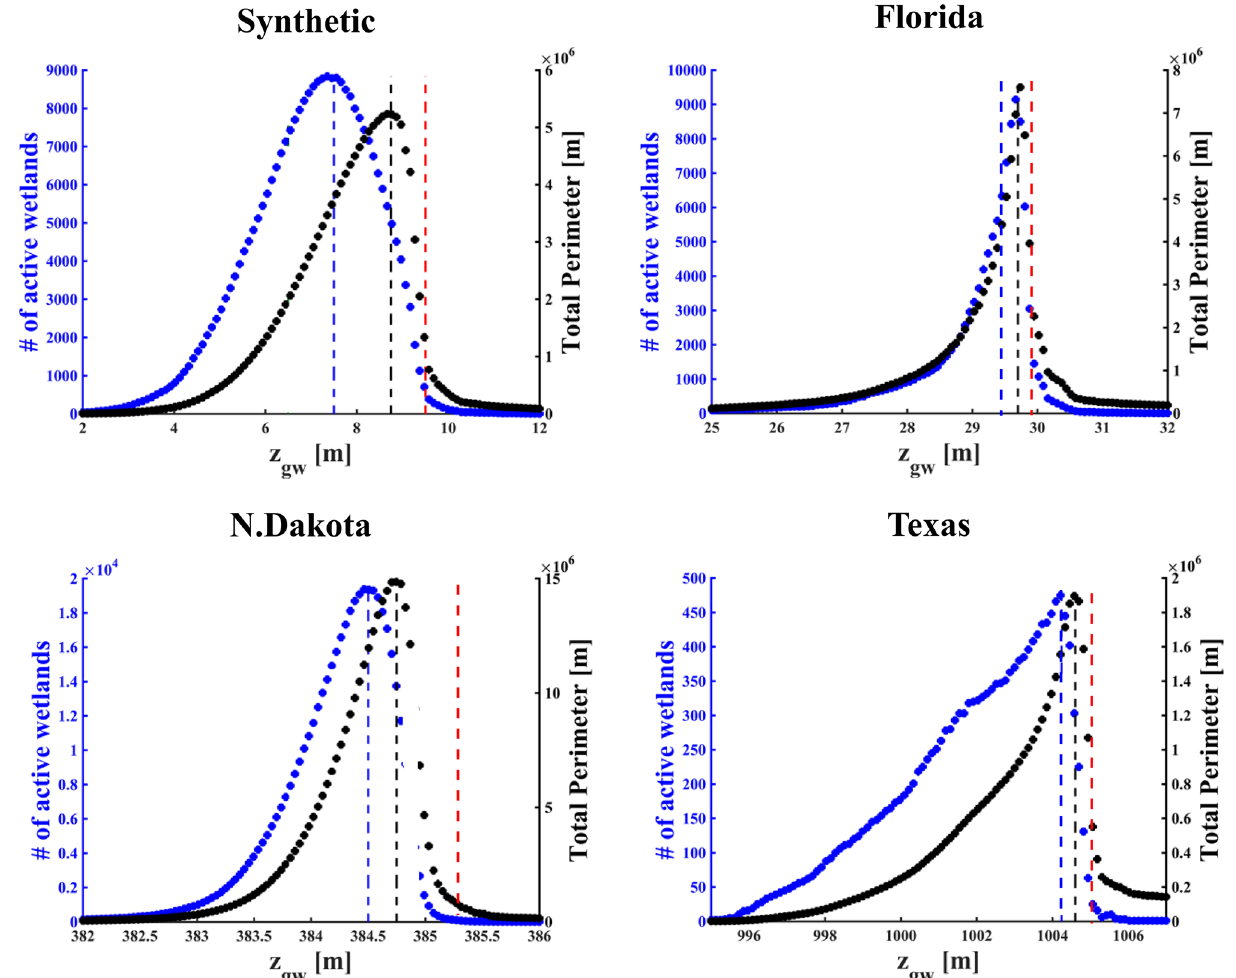
Figure 2. Comparison between the trends for the total number of active wetlands (blue circles) and the total perimeter (black circles) for different censoring levels, z gw , for DEMs of four landscapes. Dashed lines represent the thresholds that were used to compute the emergent ecological network, shown in Fig. 3. The blue and black dashed lines represent the thresholds that maximizes the number of active wetland and the total perimeter, respectively. The red dashed line stands for a censoring level z gw > z tp